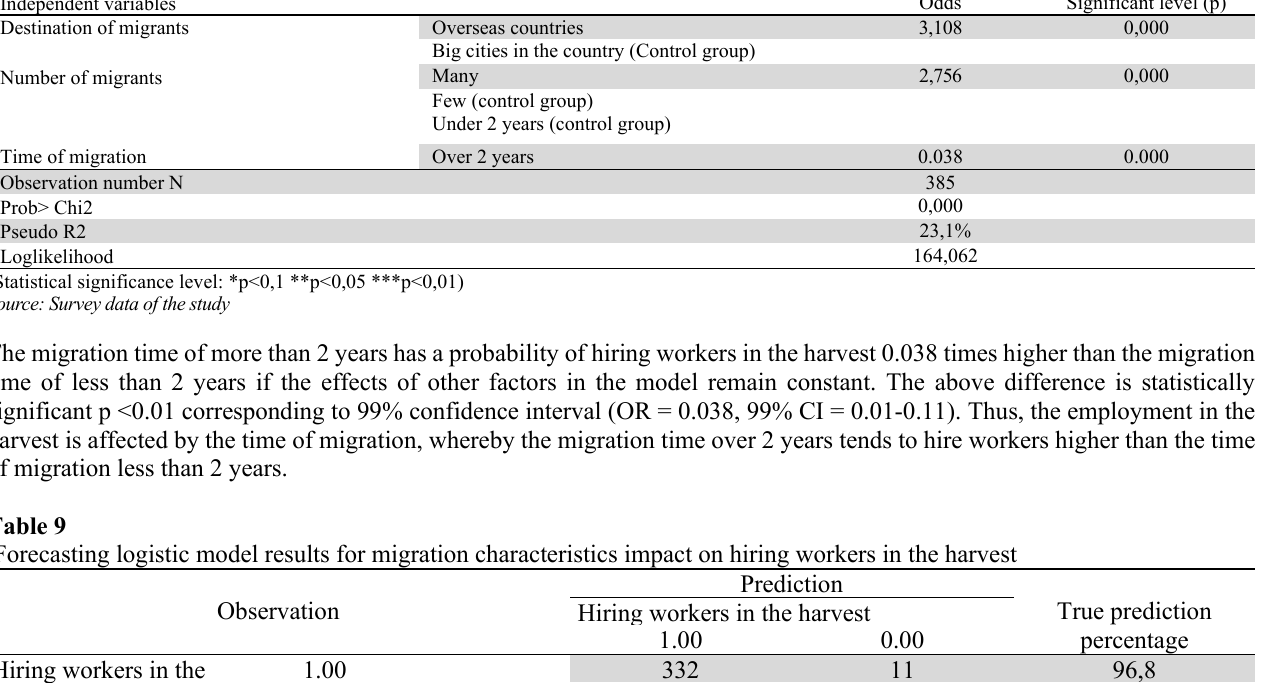
Estimated logistic model results of migration characteristics impact on hiring labor of households Independent variables